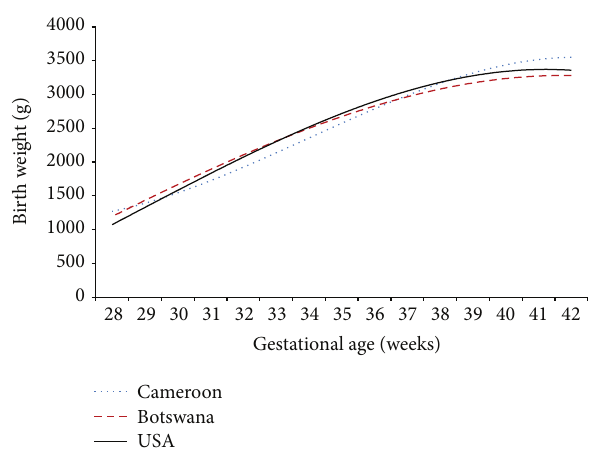
Figure 5: Median birth weights for gestational age of Cameroonian infants compared to those of Botswana and USA infants.